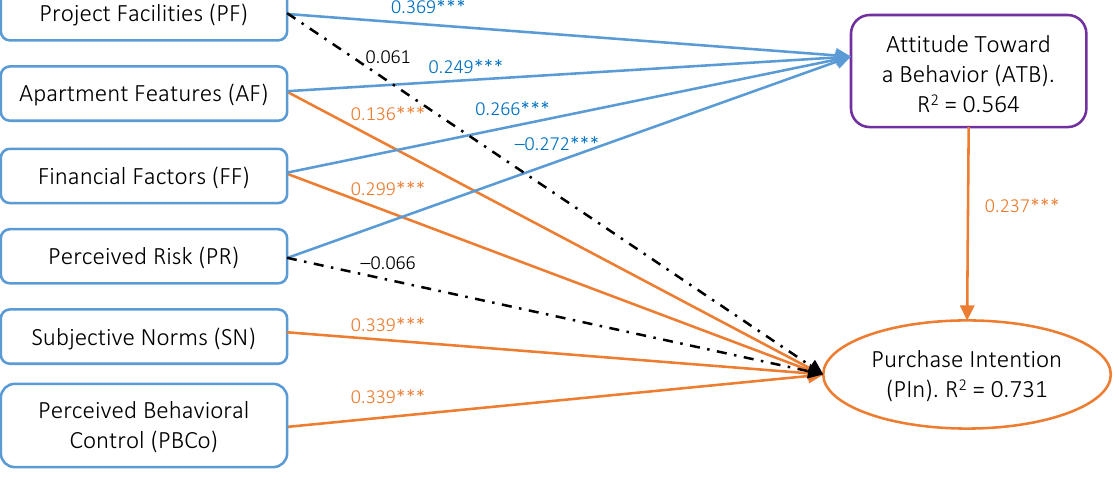
Figure 2. Standardized SEM